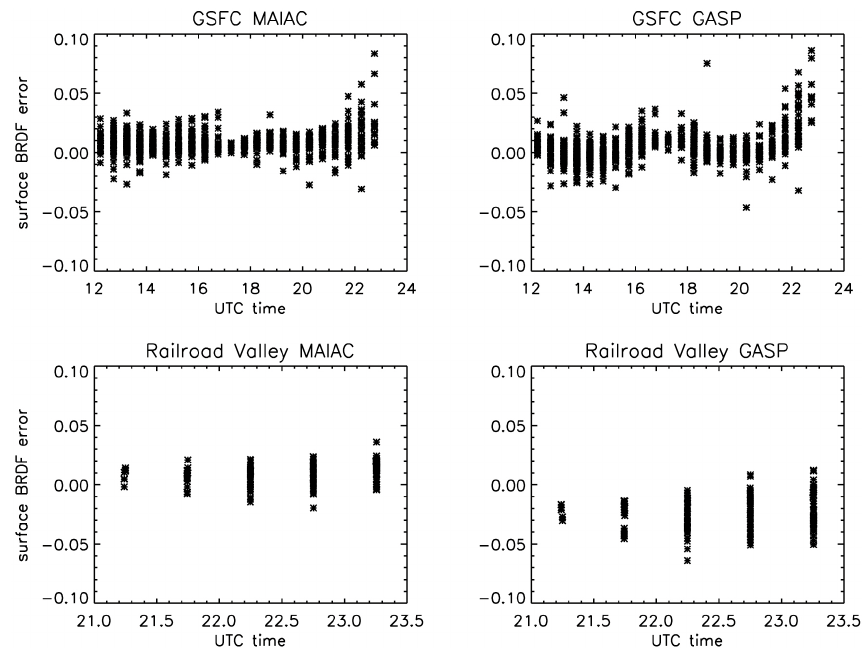
Fig. 9. Surface BRDF error at GSFC and Railroad Valley, which is defined as surface reflectance retrieval from MAIAC or GASP minus surface reflectance retrieval using GOES channel 1 data and AERONET